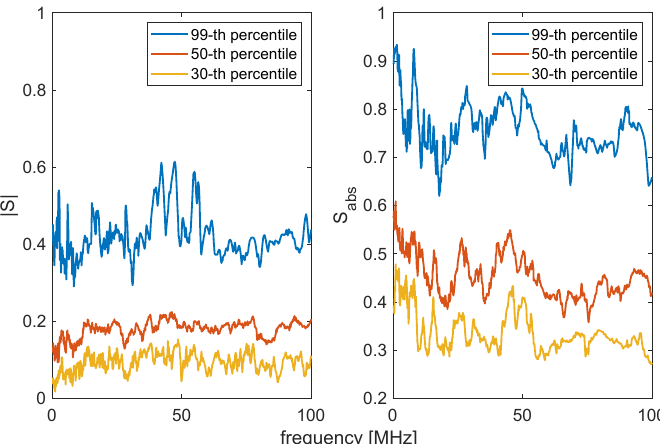
Figure 6. Correlation between the Z in and the CFTtransmitted from the same